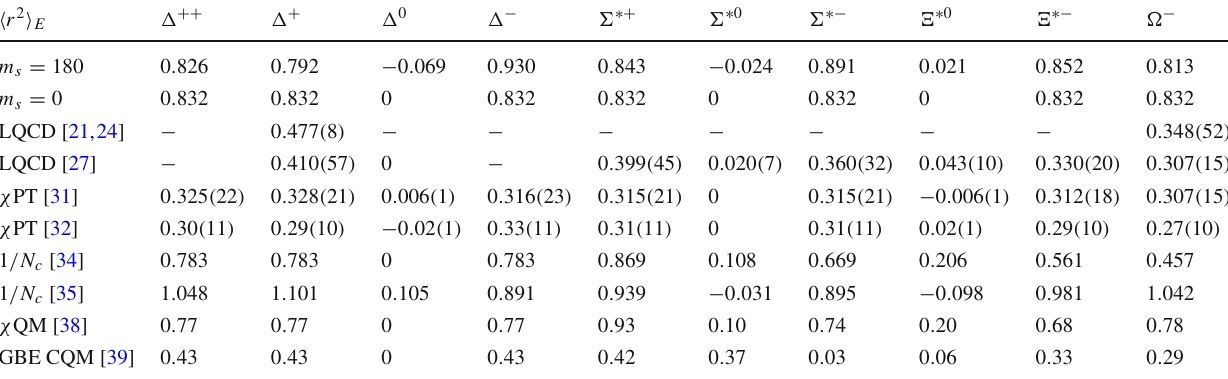
Table 1 Charge radii of the baryon decuplet in comparison with those from lattice QCD [21,24,27], the chiral constituent-quark model [39], the chiral quark model [38], large N c [34], combined chiral and 1 / N c expansion [35], covariant χ PT [31] and χ PT